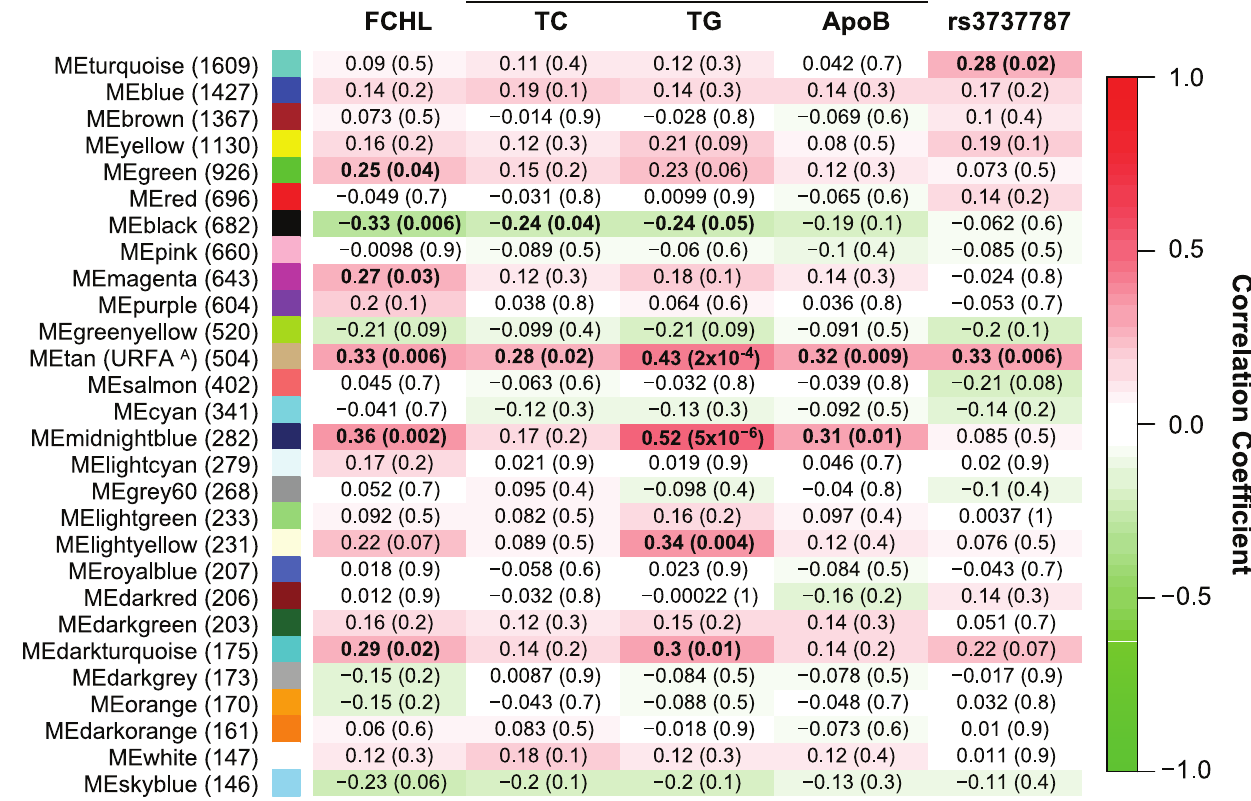
Figure 1. Correlation of module eigengenes (ME) with clinical traits and rs3737787 SNP genotypes. The rows are labeled by the ME color, and in parentheses is the number of genes in the module. The columns are labeled by SNP or clinical trait. The quantitative clinical traits, all except for FCHL which is qualitative, were corrected for significant covariates (age and/or sex) and standardized before use in analyses. The correlation coefficients are shown for each cell, and in parentheses is the p-value for the significance of the correlation. Cells are colorized based on the strength and sign of the correlation according to the scale on the right hand side of the figure. A The tan module has been renamed to the USF1 - regulated FCHL-associated (URFA)